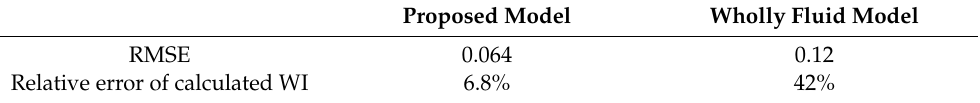
Table 3. RMSEs (evaluated using Equation (14)) and relative errors of calculated WIs corresponding to geoacoustic parameters inverted based on proposed and wholly fluid bottom models.